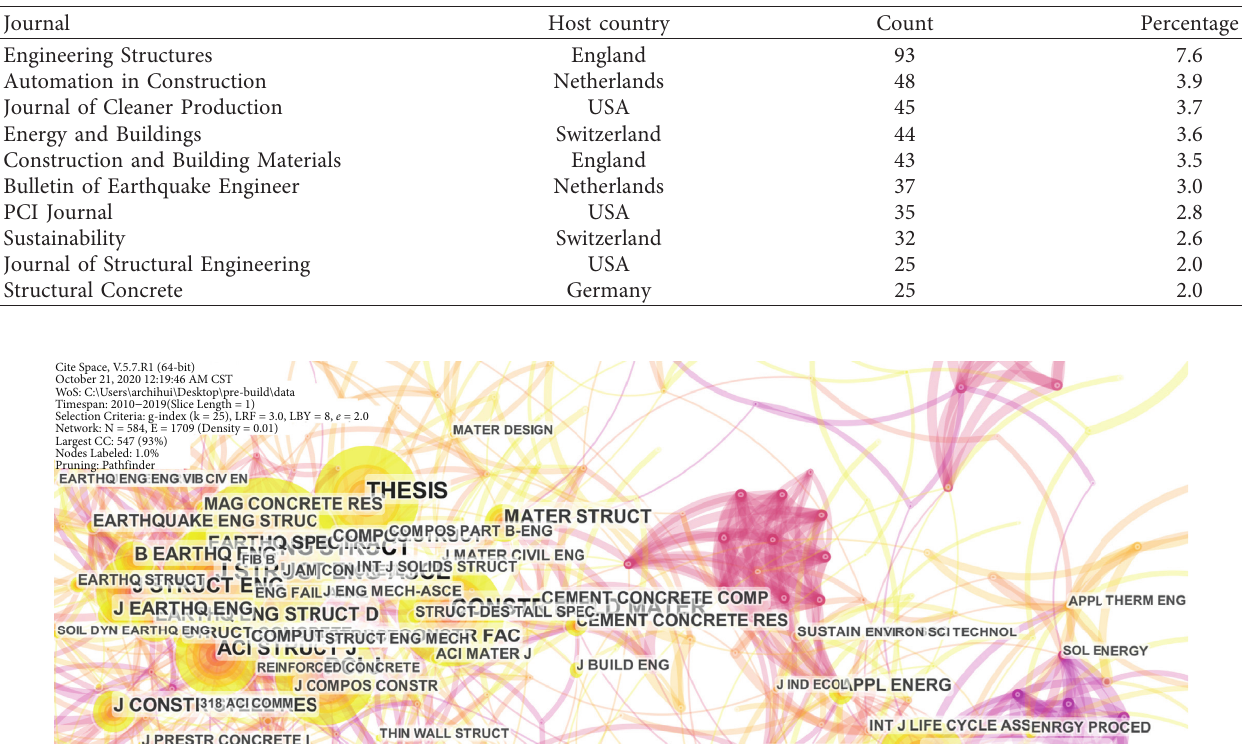
Table 6: Top 10 source journals for prefabricated building research.